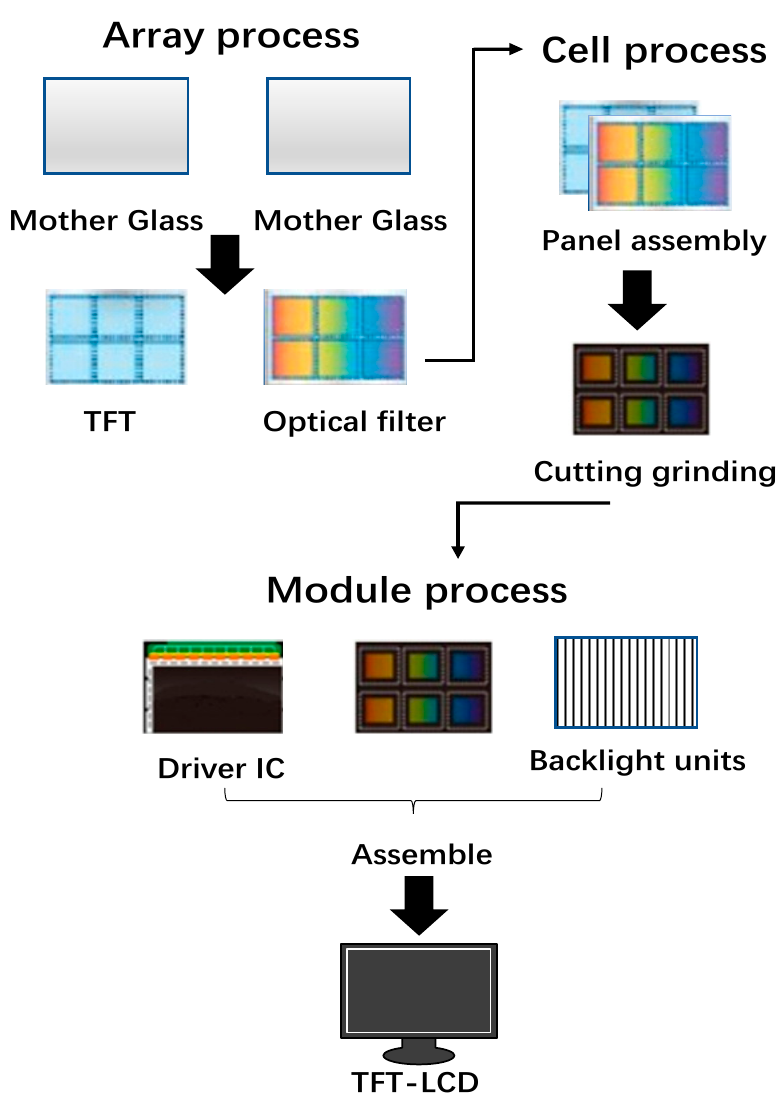
Figure 3. Manufacturing process of TFT-LCD.